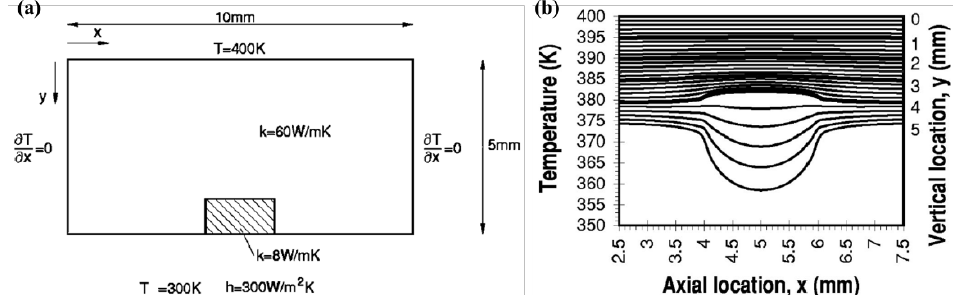
Figure 5. ( a ) Boundary conditions for a chrome steel component with a thermocouple installed in a channel filled by ceramic paste, and ( b ) calculated thermal disturbance caused by the installation of thermocouple wires [29]. Reprinted with permission from [29]. AIP Publishing, 2000.